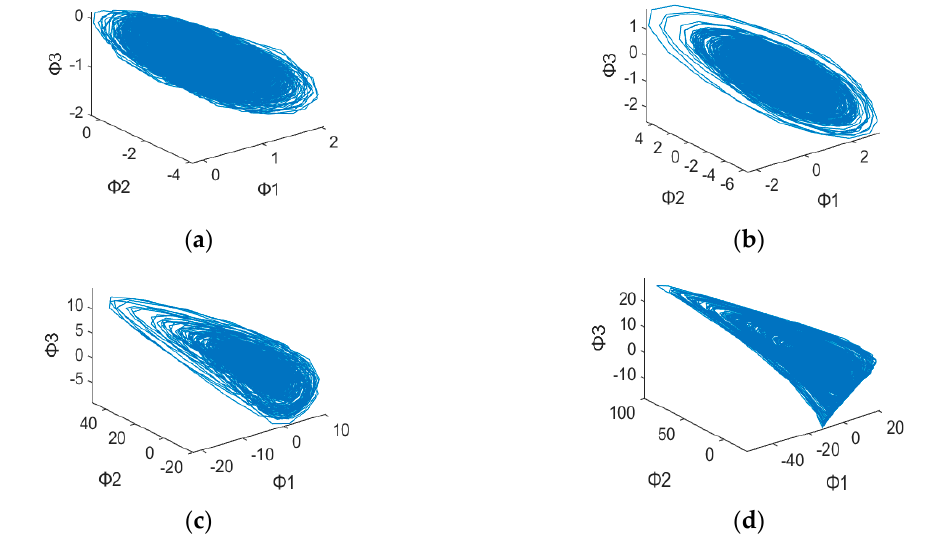
Figure 3. 3D dynamic error phase diagram of a ball bearing under testing, with α = 0, HP = 0, and SPOF diameter = 0.007 in. ( a ) Normal state. ( b ) Ball fault. ( c ) Inner race fault. ( d ) Outer race fault.